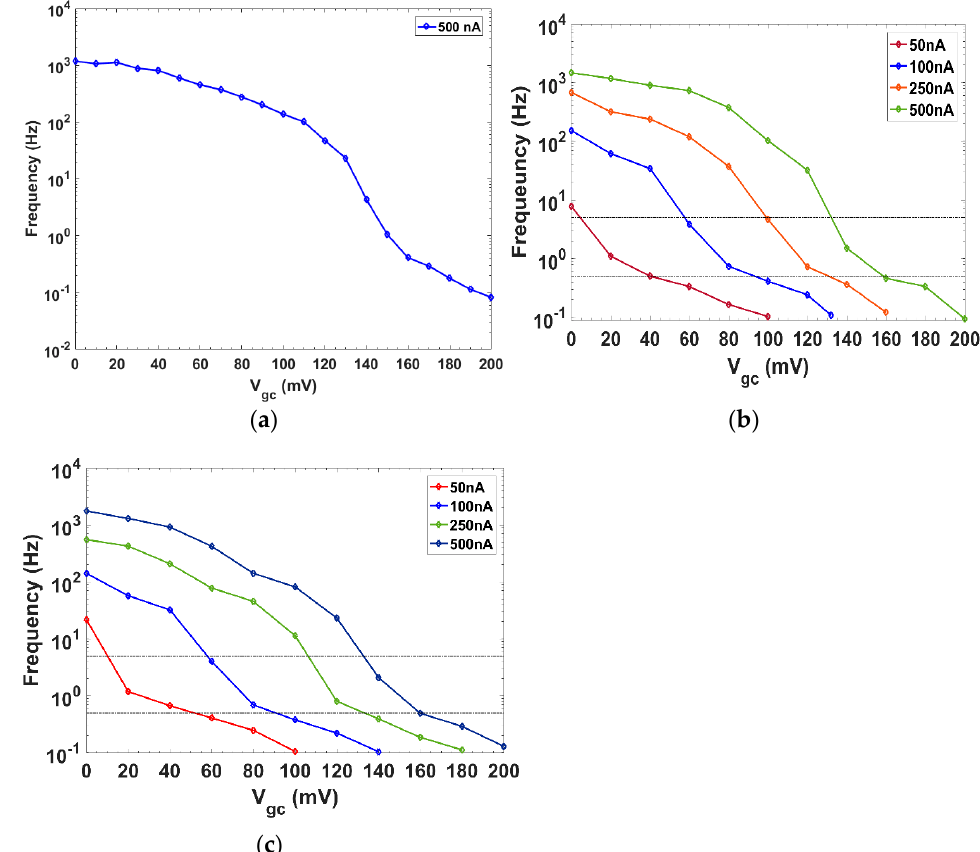
Figure 10. Cutoff frequency vs V gc for different bias currents: ( a ) Filter-1; ( b ) Filter-2; and ( c ) Filter- 3.